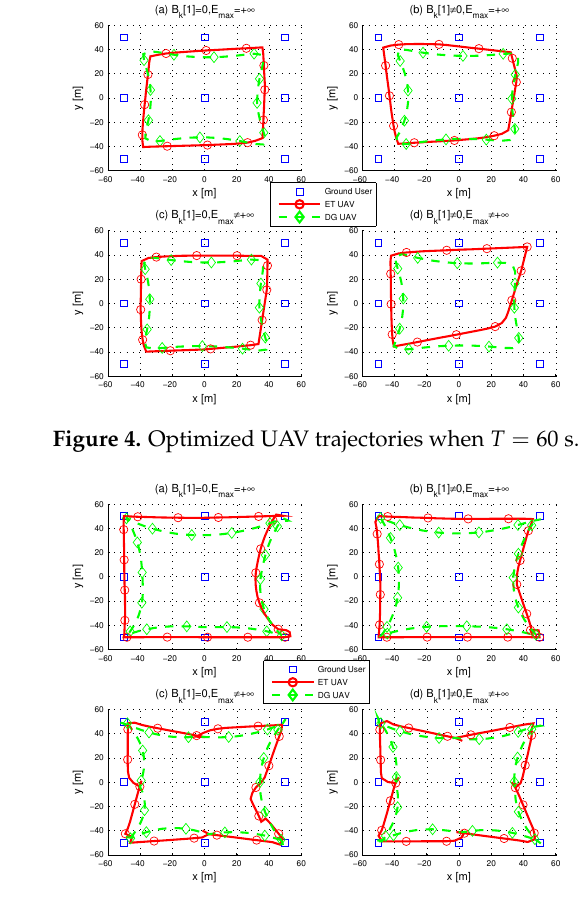
Figure 5. Optimized UAV trajectories when T = 90